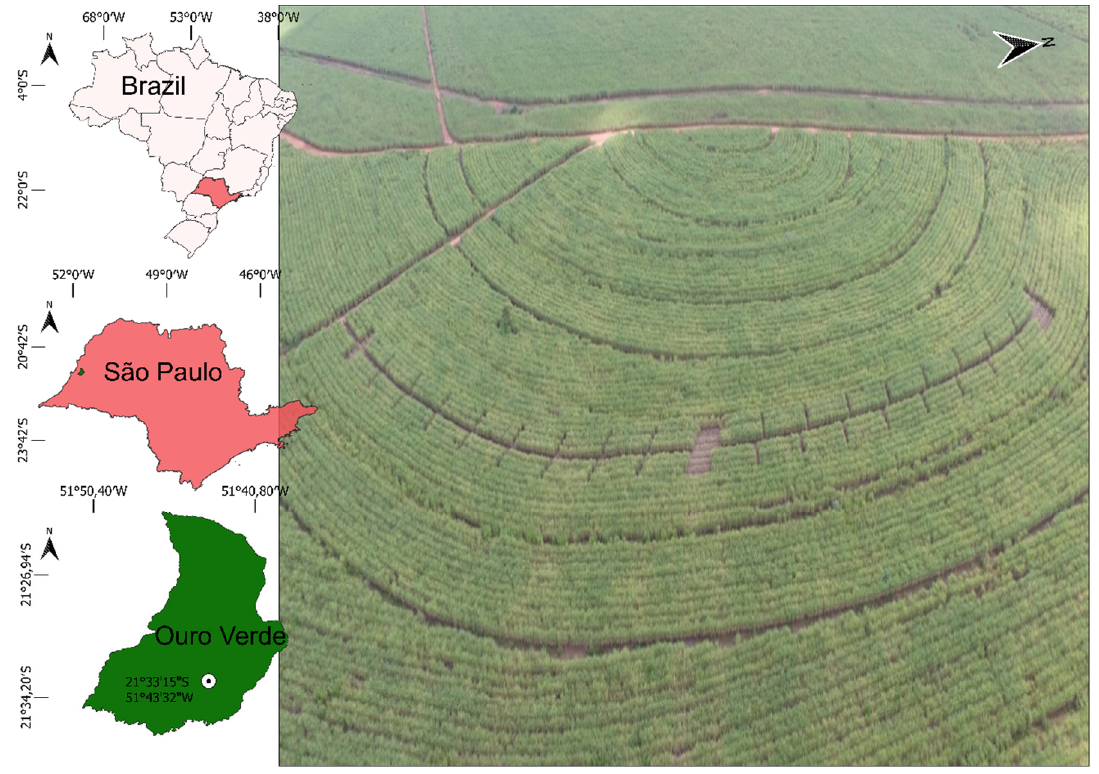
Figure 1. Location of the experimental area under sugarcane, Ouro Verde—SP, Brazil. Table 1. Soil physical and chemical properties at the beginning of the study in 2018. The experiment was arranged in a randomized complete block design with four replications, with treatments in a factorial scheme (2 × 4) + 1, represented by two sources, uncoated MAP and Policote-coated MAP (MAP + Policote) at four rates (20, 40, 60 and 80 kg P 2 O 5 ha − 1 ) and without P fertilization (control). The N and P 2 O 5 concentrations in MAP and coated MAP were 11% and 52%; and 10% and 49%, respectively. To coat the MAP fertilizer, the granules were covered with water-soluble additives based on copolymers with iron and aluminum affinity, called Policote, marketed by Wirstchat Pol í meros do Brasil. The experimental plots consisted of six 20 m long rows with alternating row spacing of 0.90 and 1.5 m on a total area of 144 m 2 . Planting of the crop occurred in 2015, with the first cut in 2016 (plant-cane), the second cut in 2017 (first ratoon) and the experiment installed on 16 October 2018 (second ratoon). Phosphate fertilizers were applied on the crop row together with 120 kg N ha − 1 (34 and 86 kg ha − 1 , respectively, of ammonium sulfate-N and N urea) and 120 kg K 2 O ha − 1 (potassium chloride), in both growing seasons (2018/20 and 2019/20). After the second cut, 2 Mg ha − 1 of limestone was